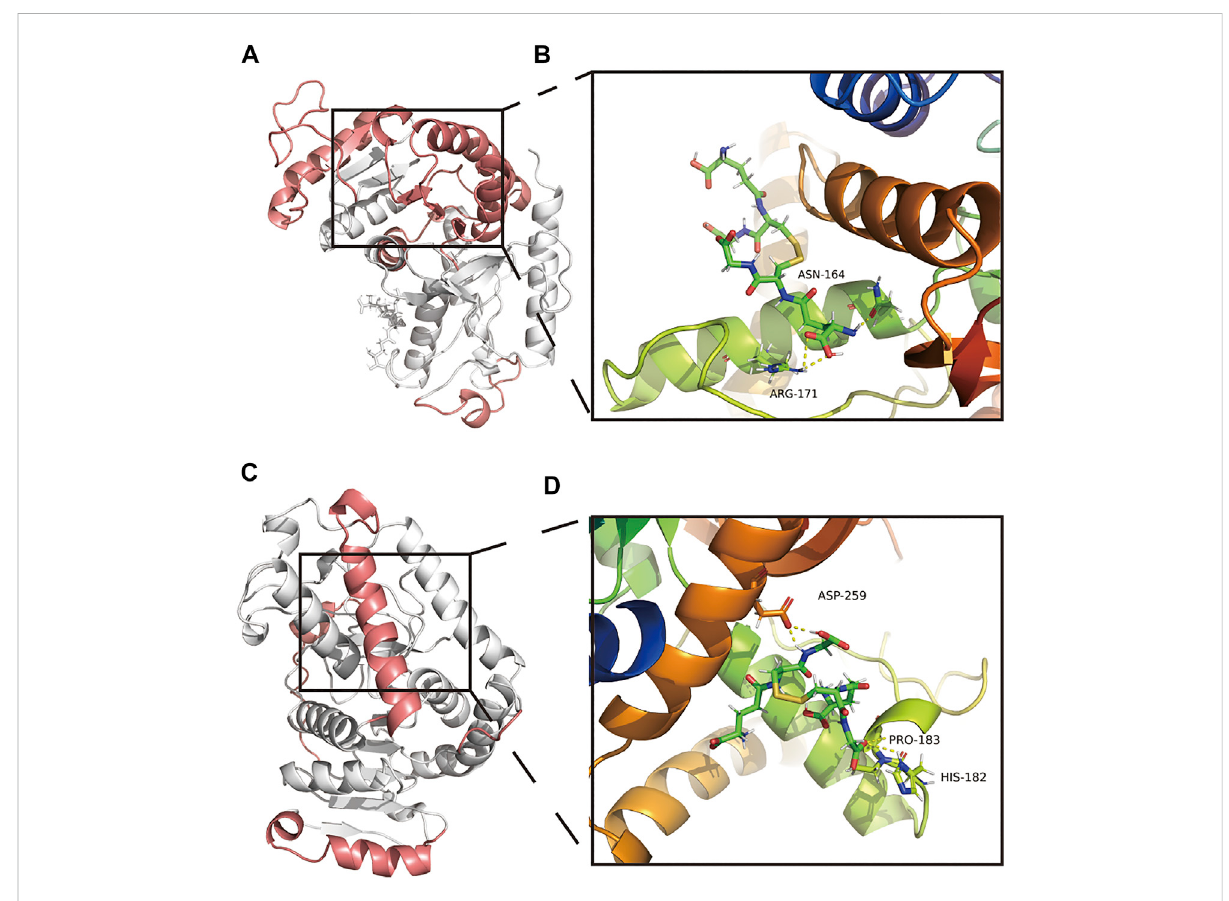
FIGURE 8 Amino acid interactions of the stable structure. (A,B) Amino acid interactions of GSSG-LDHA complex MDS after obtaining stable structures. (C,D) Amino acid interactions of GSSG-LDHB complex MDS after obtaining stable